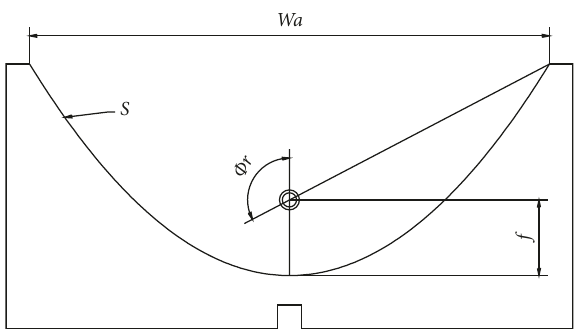
Figure 3: Proposed parabolic